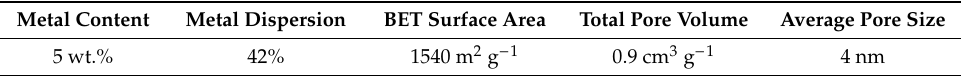
Table 1. Characterization results of the Pd